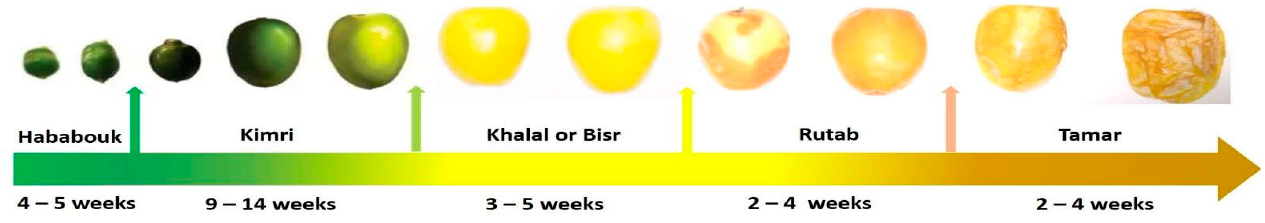
Figure 1. Different growth and maturity stages of Barhi date fruit (post ‐ anthesis weeks).